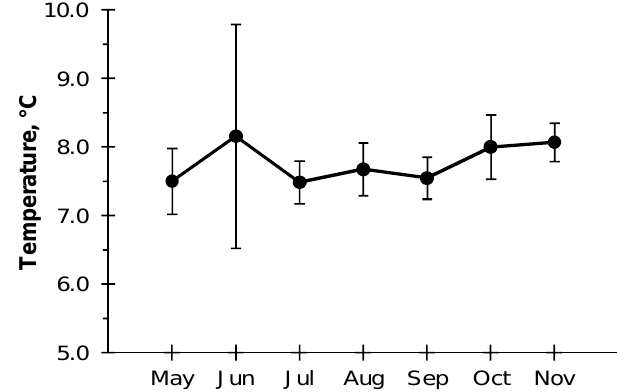
Fig. 6. Intra-seasonal variability (May–November) of absolute tem- perature ( ◦ C) in the BSW. Error bars show 1 standard deviation due to variations of BSW temperature in individual nodes of the climate